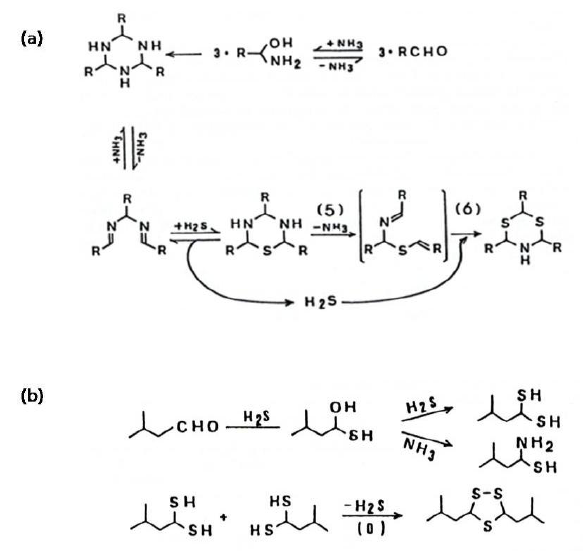
Figure 7. Possible mechanisms for the formation of (a) dithiazines and (b) 3,5-diisobutyl-1,2,4-trithiolane (Shi and Ho,